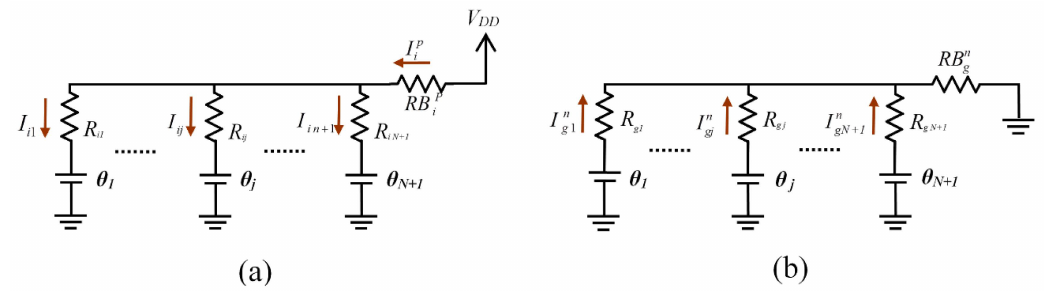
Figure 6. Detail of the circuit for calculation of currents during activation of row i . ( a ) Currents for the selected row i . ( b ) Currents for a non-selected row g